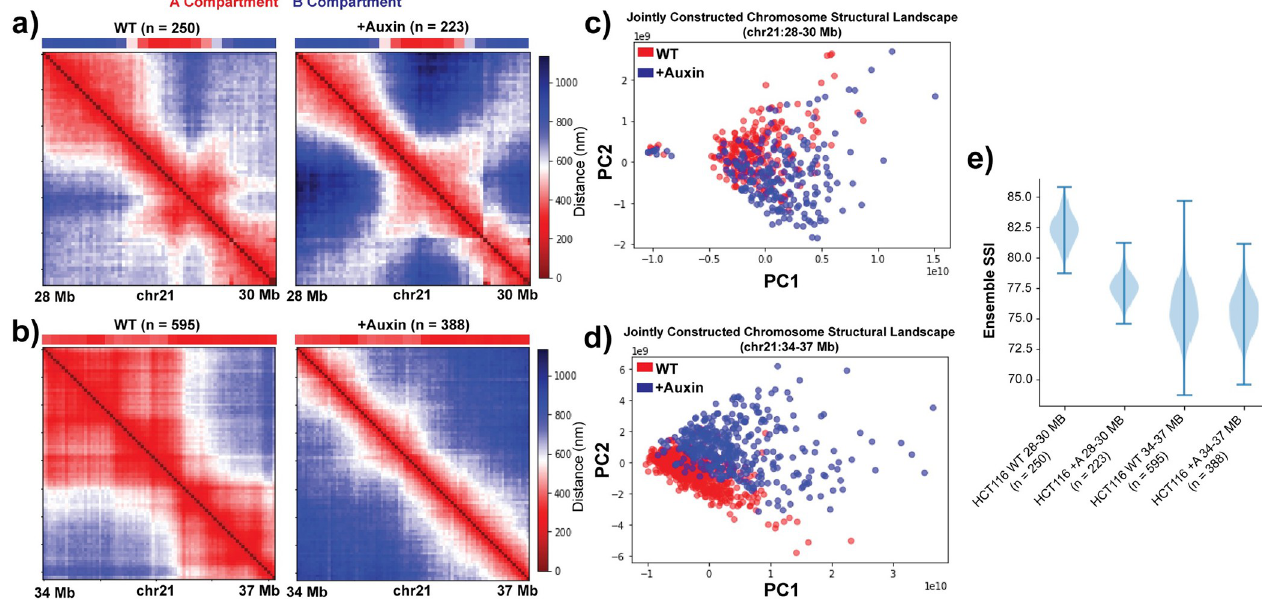
Fig 6. Cohesin depletion alters chromosome structural heterogeneity depending on underlying epigenetic state constraints. a,b) Population-averaged distance maps of HCT116 chr21:28–30 Mb (a) or chr21:34–37 Mb (b) at 30 kb resolution for wild-type (WT) and cohesin-depleted (+Auxin) conditions based on data obtained from Bintu et al . (37]. Compartment status from Hi-C data at these locations shown above each matrix. c,d) Jointly constructed chromosome structural landscapes of chr21:28–30 Mb (c) or chr21:34–37 Mb (d) of HCT116 for WT and +Auxin conditions. e) Chromosome structural ensemble SSI distributions for different local chromosome regions of HCT116 for WT and +Auxin conditions. 200 single-cell structures are selected randomly each time for resampling.